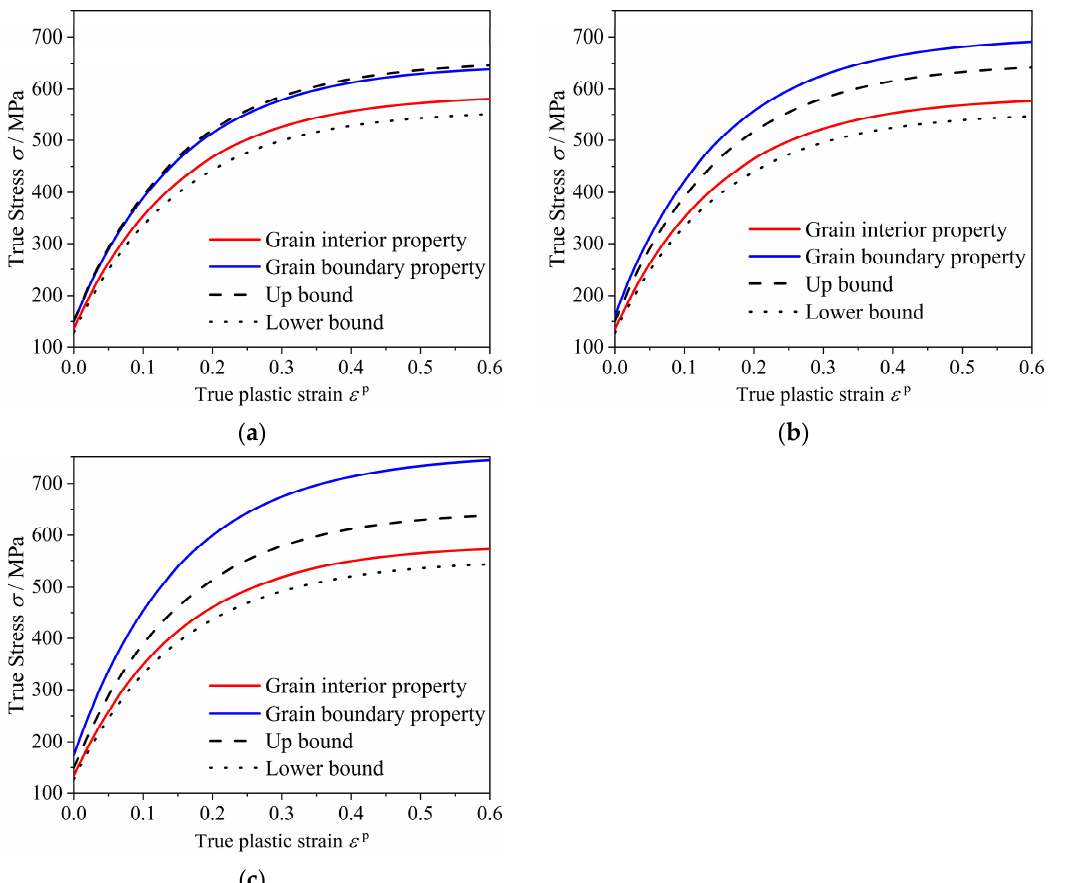
Figure 10. Distribution of mechanical properties about grain boundary and grain interior at 9.65 A/mm 2 with 95 μ m: ( a ) K = 1.1; ( b ) K = 1.2; ( c ) K = 1.3.